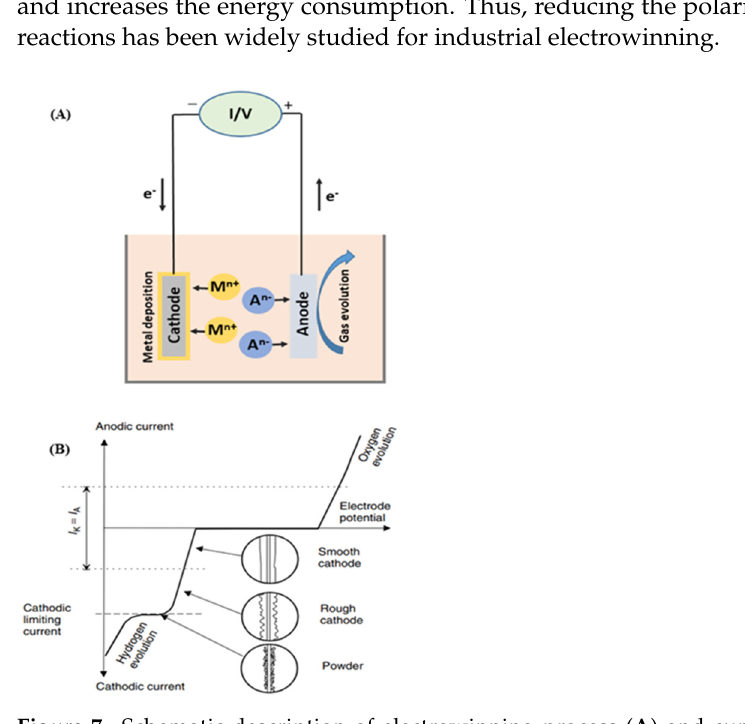
Figure 7. Schematic description of electrowinning process ( A ) and current density–cell voltage dependence for the electrowinning of copper ( B ). Reproduced with permission [16]. Copyright 2007,